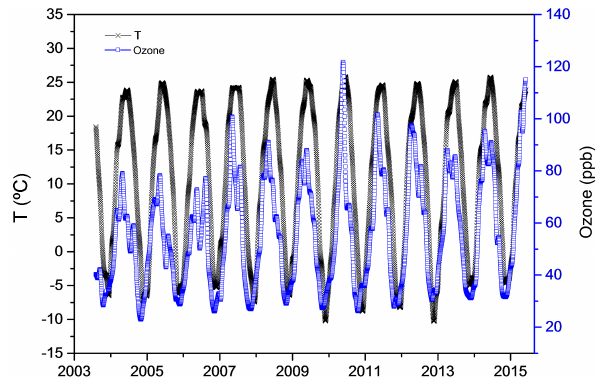
Figure 5. Results of the daily mean temperature and the MDA8 value of ozone after the application of the KZ 15 , 5 filter to the orig- inal time series. The results indicate the sum of the seasonal and long-term components.